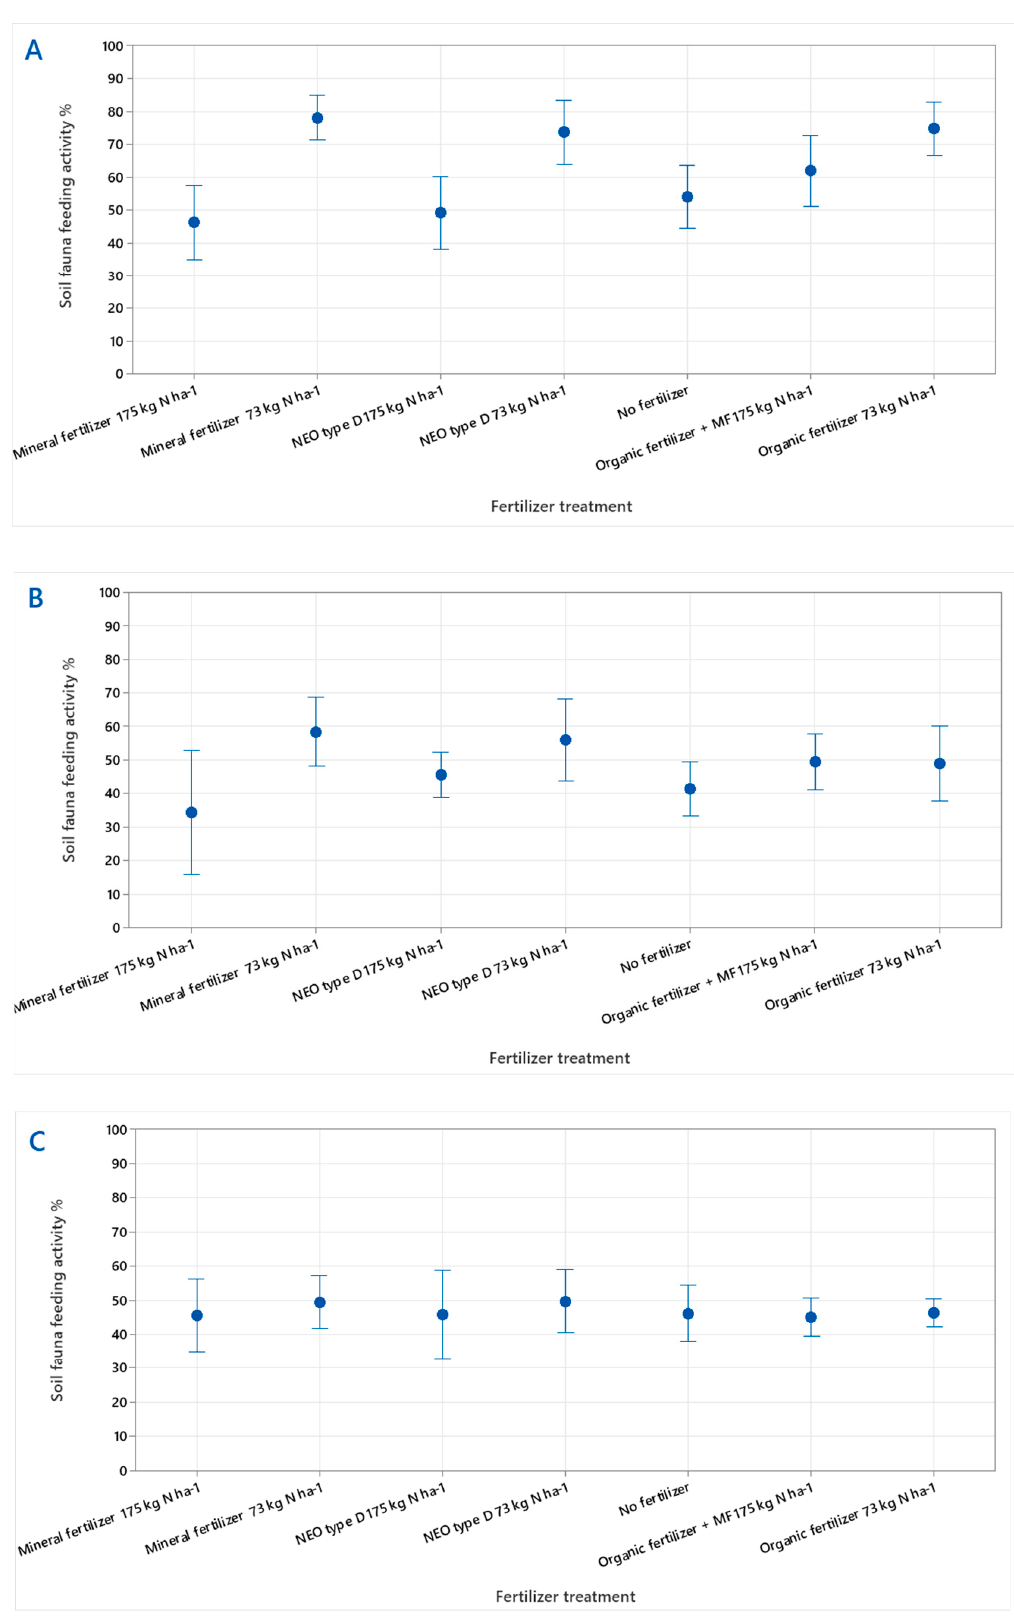
Figure 1. Effects of different fertilization treatments on soil fauna feeding activity (%) ( A ) seven weeks after fertilizing, ( B ) 14 weeks after fertilizing (7–14 weeks), and ( C ) 21 weeks after fertilizing (14–21 weeks). Error bars are individual standard deviations at a 95% confidence interval.